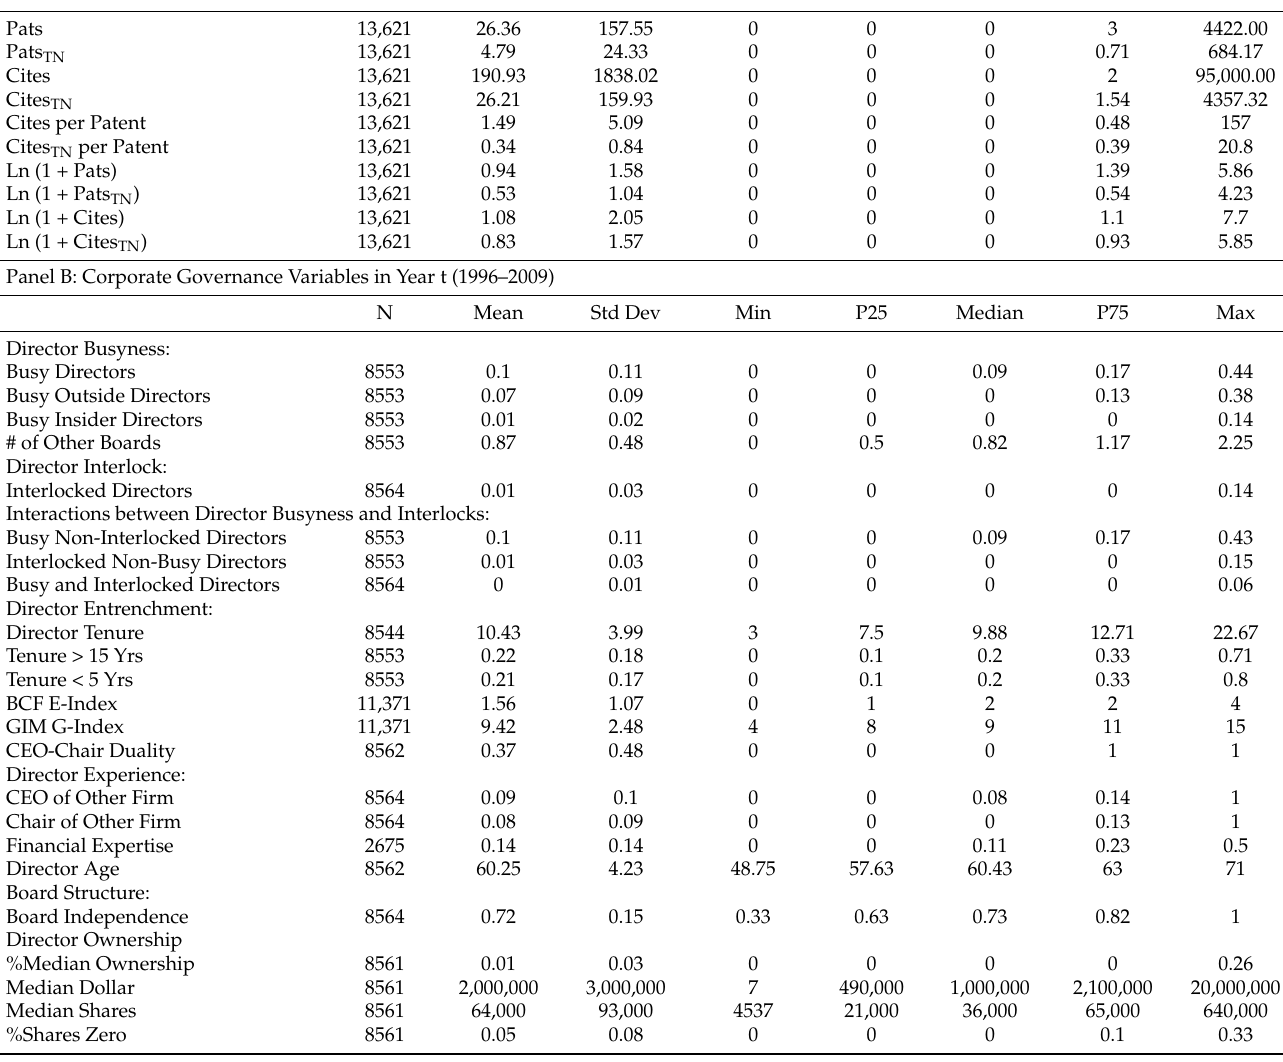
Table 1. Summary Statistics. This table provides summary statistics on the key Innovation, Gover- nance and control variables. All variables except binary variables are winsorized at the upper and lower 1% level. Panel A presents the corporate innovation variables; Panel B presents the corporate governance variables; Panel C presents the firm-level control variables. All variables are defined in the Appendix